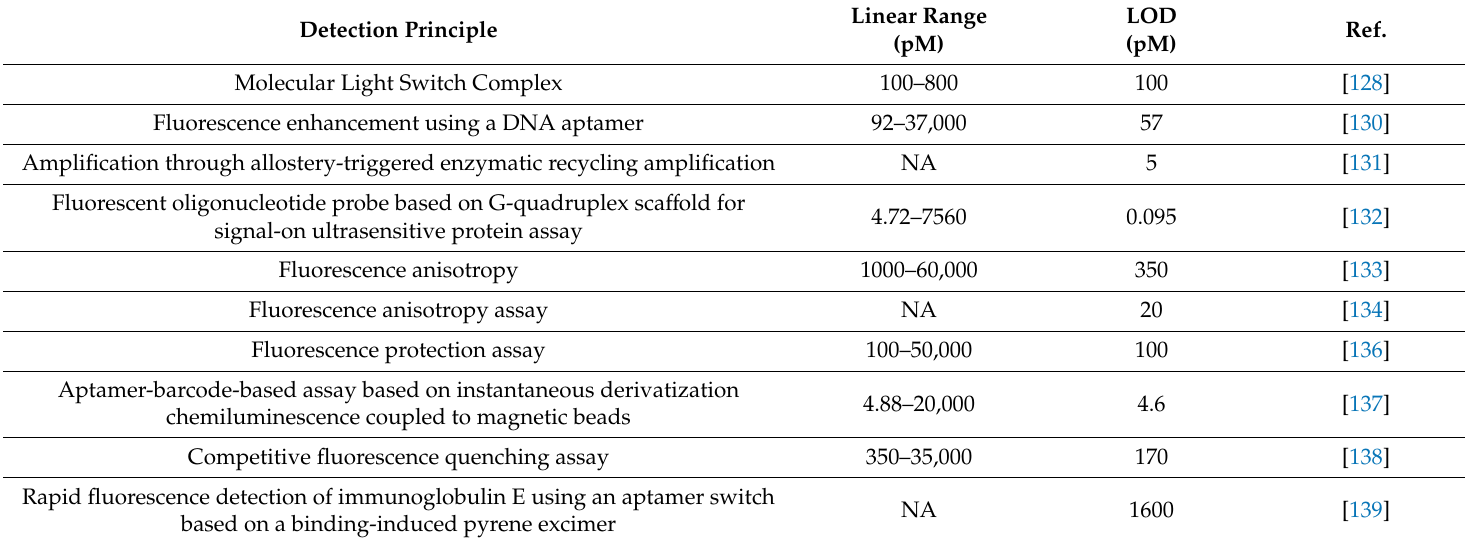
Table 11. Homogeneous fluorescence-based IgE